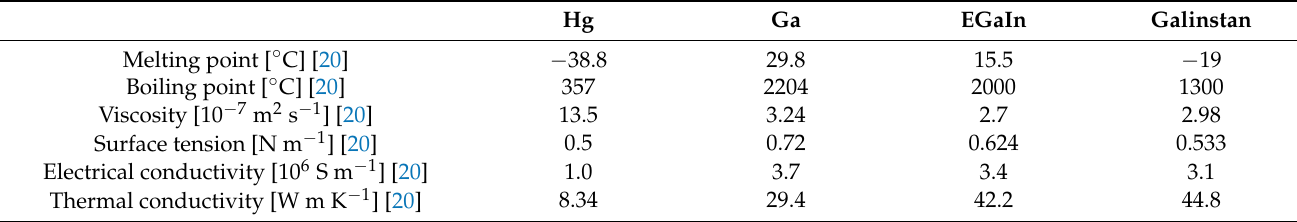
Table 1. Physical properties of commonly used liquid metals. Reprinted with permission from Ref. [20]. Copyright 2018 John Wiley and Sons. Hg Ga